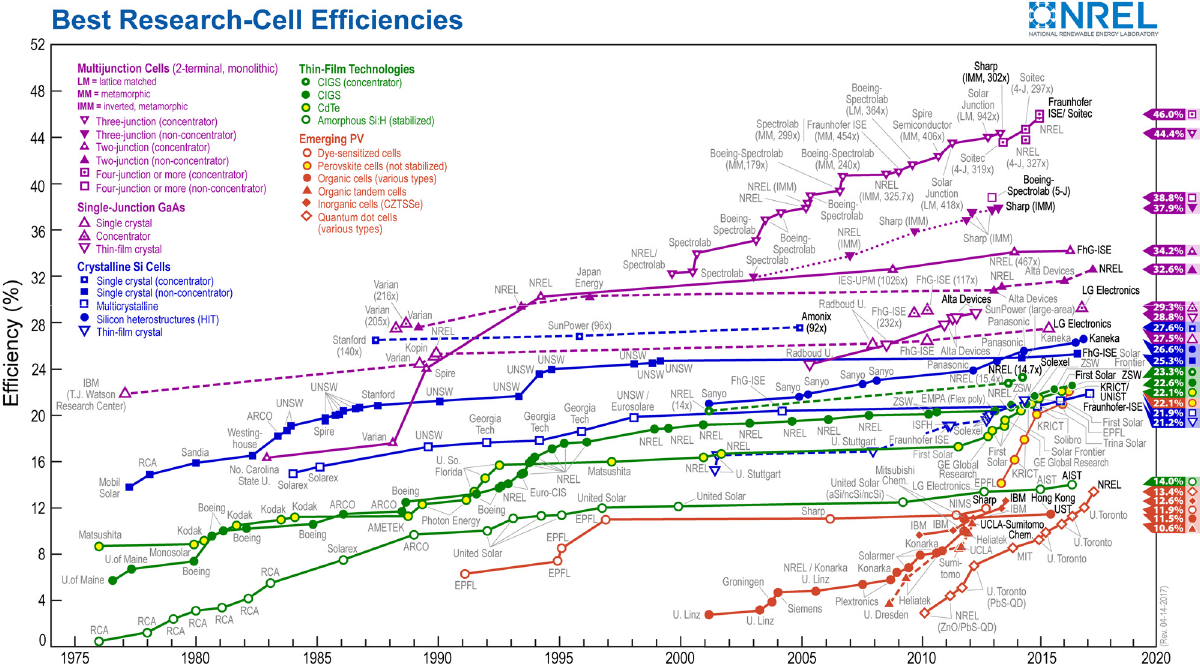
Figure 18: Evolution of solar cell technologies. ( Retrieved from the NREL website: www.nrel.gov/pv.